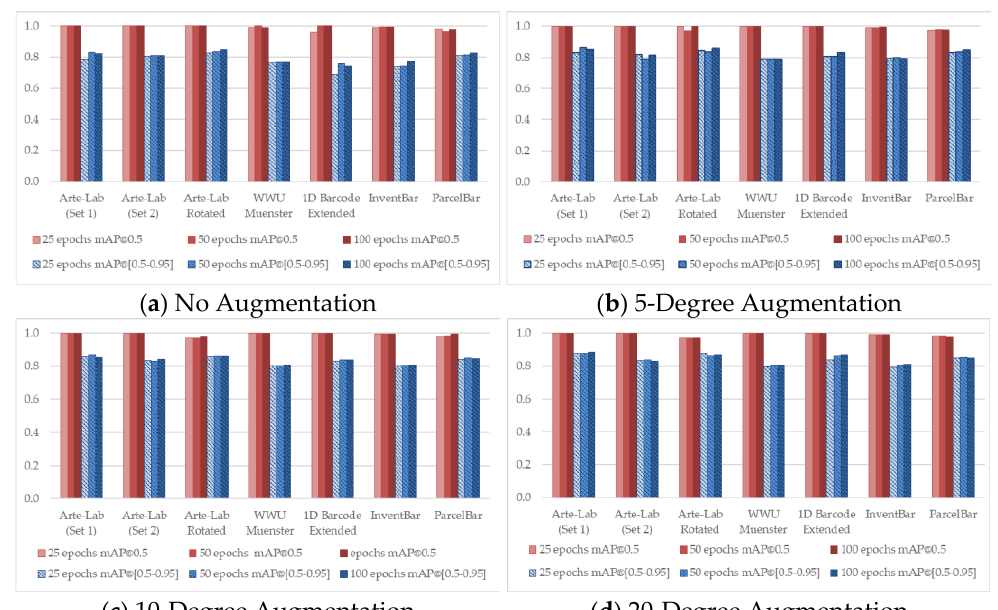
Figure 5. Recognition rate of Faster R-CNN applied over seven public barcode datasets.